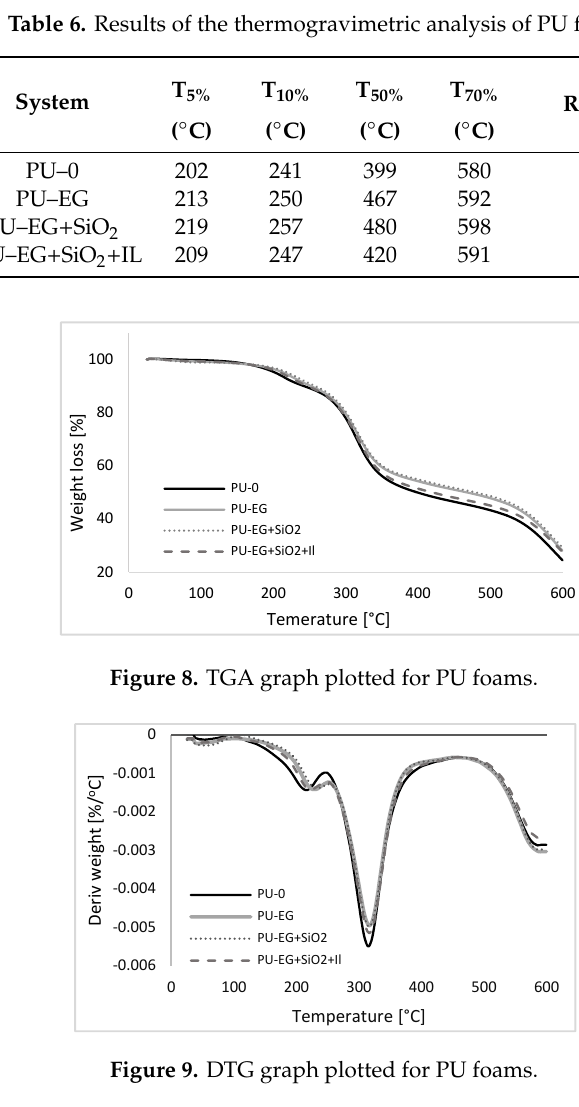
Table 6. Results of the thermogravimetric analysis of PU foams.